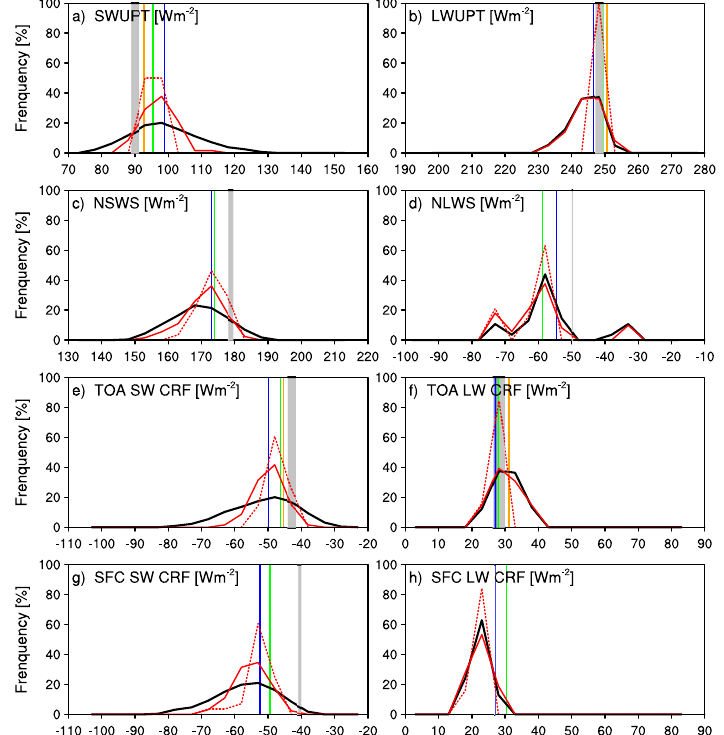
Fig. 5. The CAR member frequency distributions (thick black curves) in predicting the top and surface net radiative fluxes (a–d) ,Wm − 2 ) and cloud radiative forcings (CRF, (e–g) ,Wm − 2 ) averaged over [60 ◦ S–60 ◦ N] in July 2004 for SW (left) and LW (right) to a subset of 448 members. The red curves are the respective results from the subset with the observational constraints on NSWT and NLWT separately (dashed) and their sum (solid). The CAR ensemble mean (black) is compared with the observational data from ISCCP (red), SRB (green), various versions of CERES (purple shading), and CERES EBAF